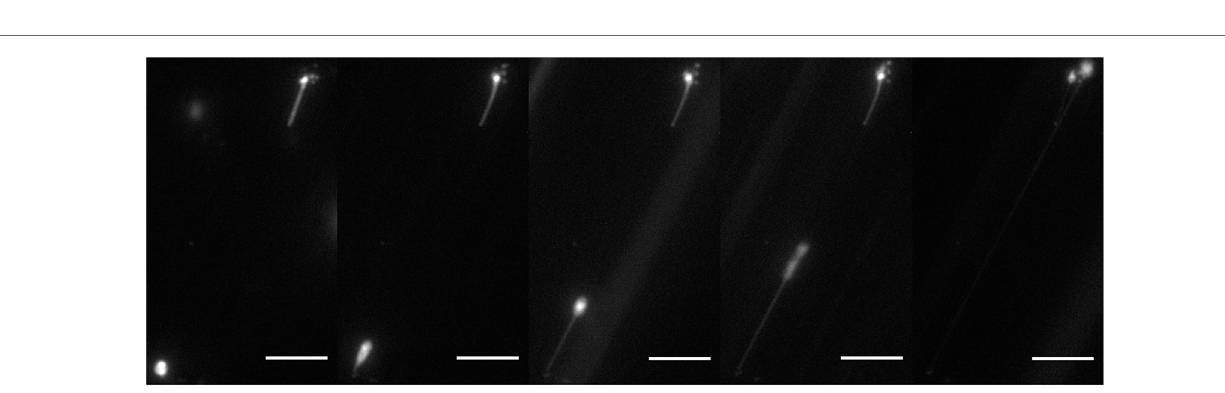
FigUre 4 | Fluorescence microscopy of lipid tubulation under high flow . A lipid nanotube was extracted from a DOPC/DGS-NTA (5 mol%) GUV of 2 μ m in diameter by the applied flow. The nanotube was about 57 μ m in total. Scale bar: 10 μ